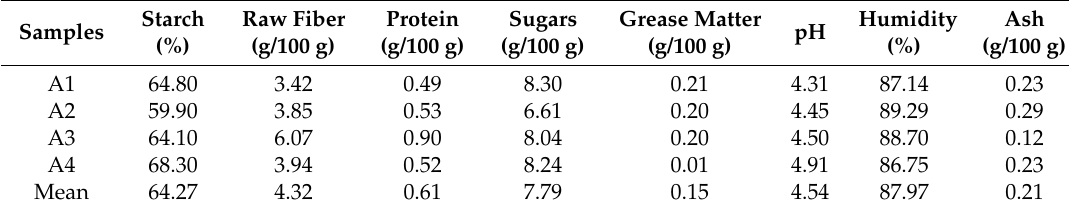
Table 1. Physical and chemical characterization of samples before hydrolysis.